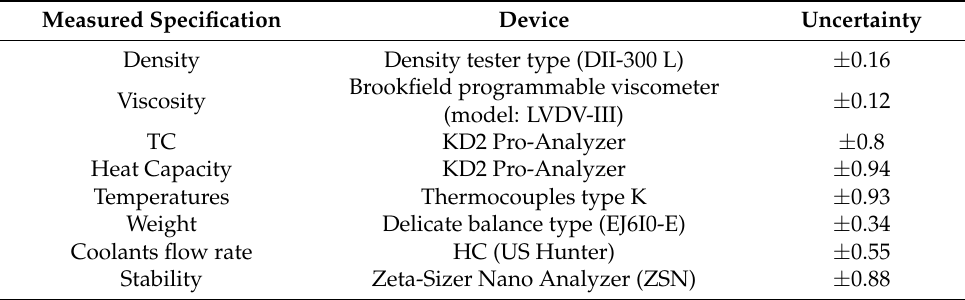
Table 5. The details and uncertainties of the measuring devices used in the tests. Measured Specification